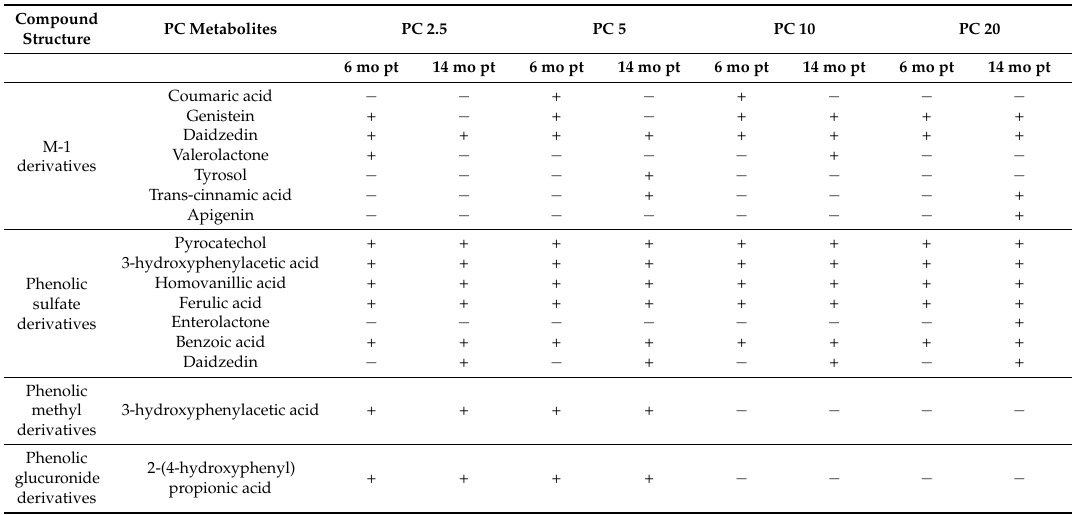
Table 1. Excretion of phenolic compounds (PC) metabolites in the urine after 6 and 14 months of consumption of PC-rich grape pomace